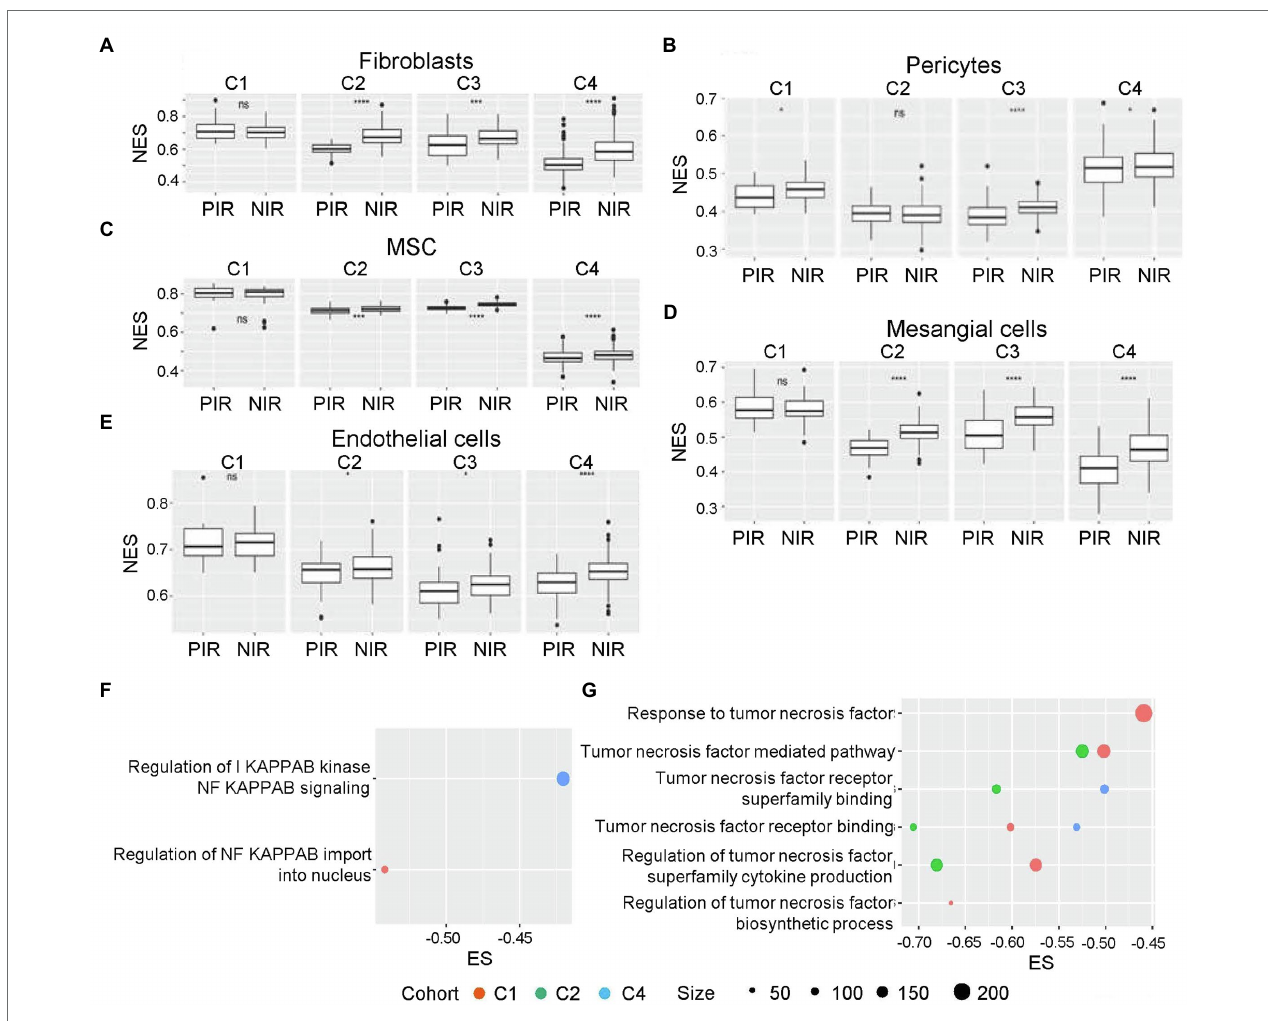
FIGURE 4 | NES distributions in NIR and PIR clusters. (A) Fibroblasts, (B) pericytes, (C) mesenchymal stem cells (MSCs), (D) mesangial cells, and (E) endothelial cells. ns, p > 0.05; * p ≤ 0.05; ** p ≤ 0.01; *** p ≤ 0.001; and **** p ≤ 0.0001. Enrichment scores for GO terms associated with the mesenchymal differentiation-related cytokines (selected according to a p < 0.05; F ) NF- κ B and (G) tumor necrosis factor (TNF)- α . GO, Gene Ontology; MSC, mesenchymal stem cell; NES, normalized enrichment score; NF- κ B, nuclear factor-kappaB; NIR, negative immune response; PIR, positive immune response; and TNF- α , tumor necrosis factor- α